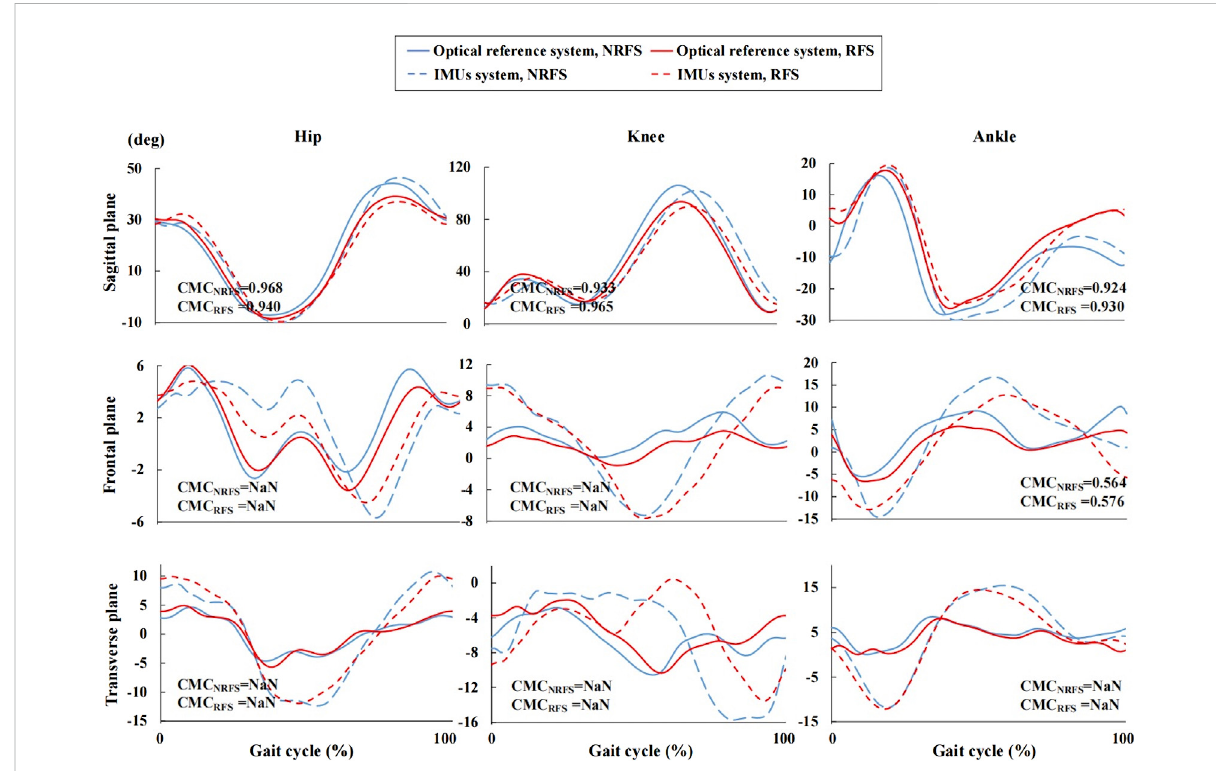
FIGURE 4 Joint anglewaveformsduring gaitcyclemeasuredbytheinertialmeasurementunits andopticalreferencesystemafter offsetcorrection. NRFS non-rearfoot strike pattern; RFS rearfoot strike pattern; IMUs inertial measurement units; CMC NRFS the coef fi cient of multiple correlation of the two systems inNRFSrunners; CMC RFS thecoef fi cient of multiple correlation ofthe twosystems in RFSrunners; NaN indicates that the CMC isacomplex